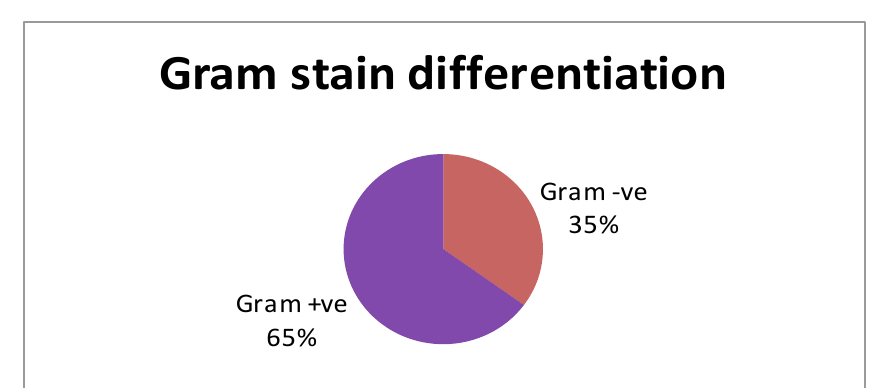
Figure (2): Gram stain differentiation